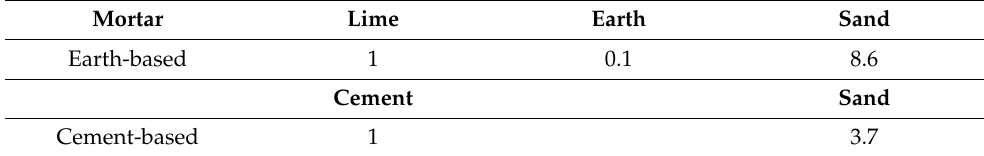
Table 1. Earth-based and cement-based samples mix design (by weight).